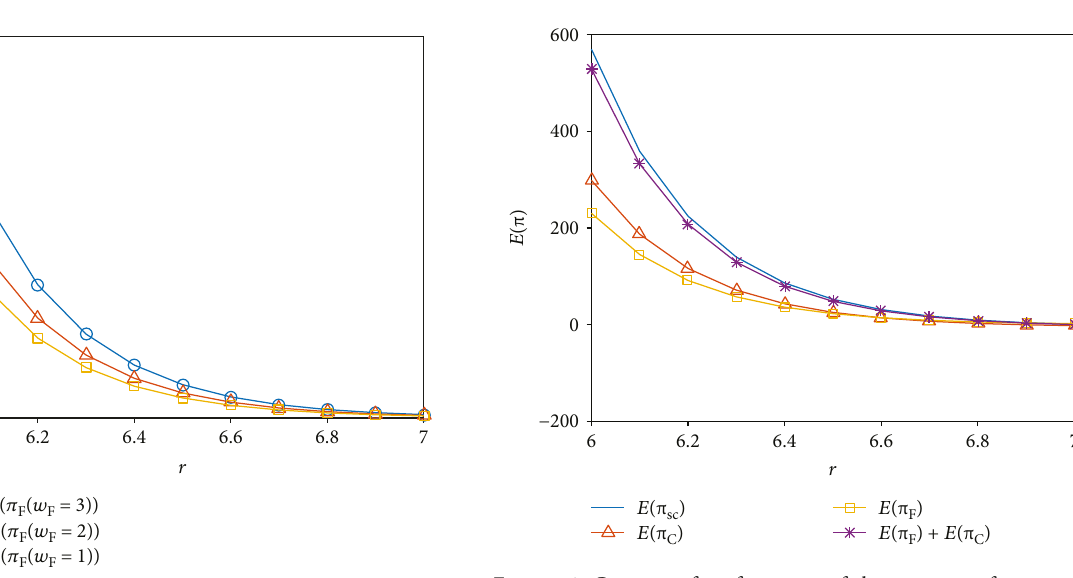
Figure 2: E ff ect of rainfall on farmer ’ s performance under di ff erent reservation prices.